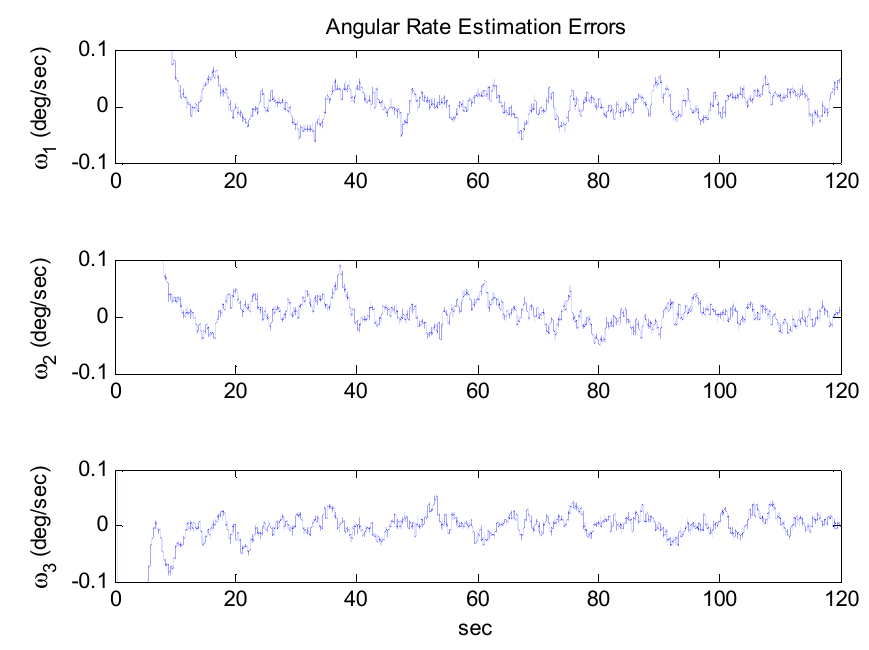
Figure 5. Angular rate estimation errors: Case 1.